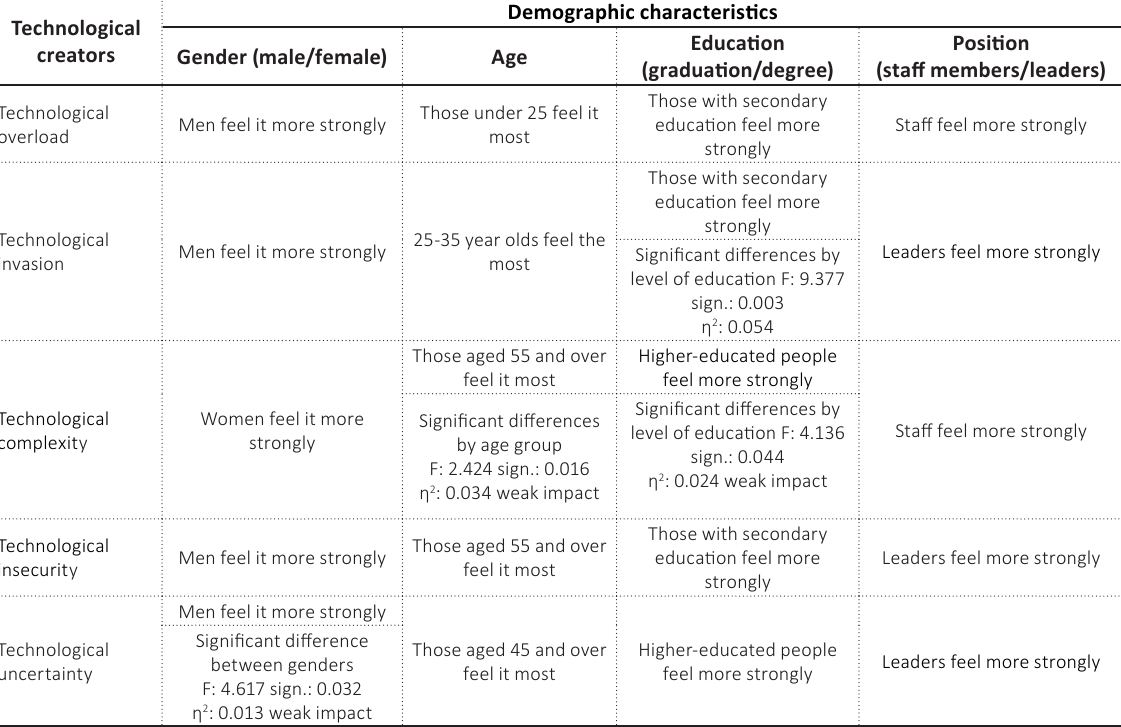
Table 5. Perception of technological phenomena in the light of demographic characteristics